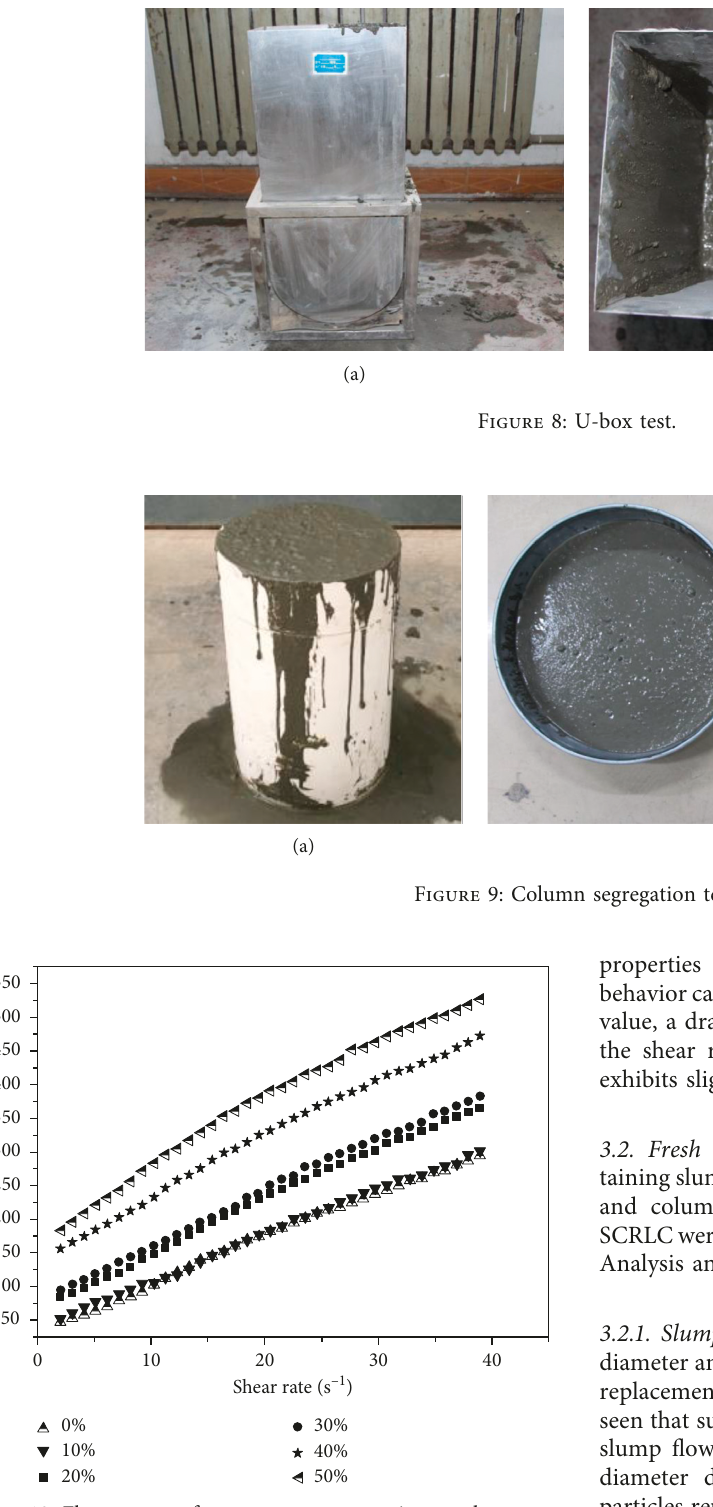
Figure 10: Flow curves of mortar pastes on various replacement levels of rubber